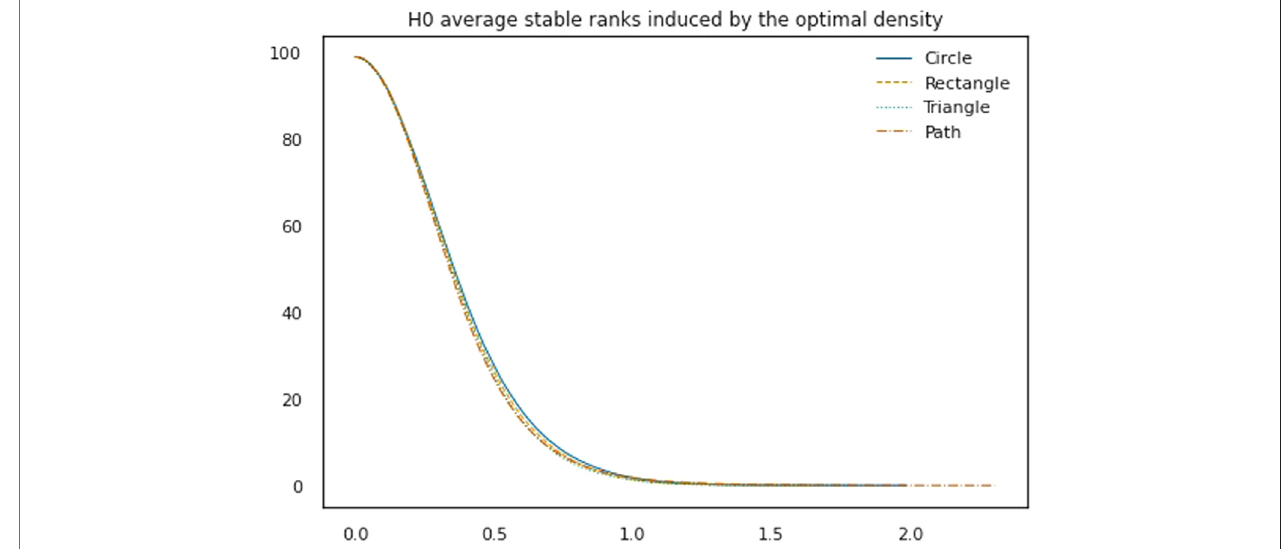
FIGURE 3 | Average 0-th homology standard stable ranks for each shape.